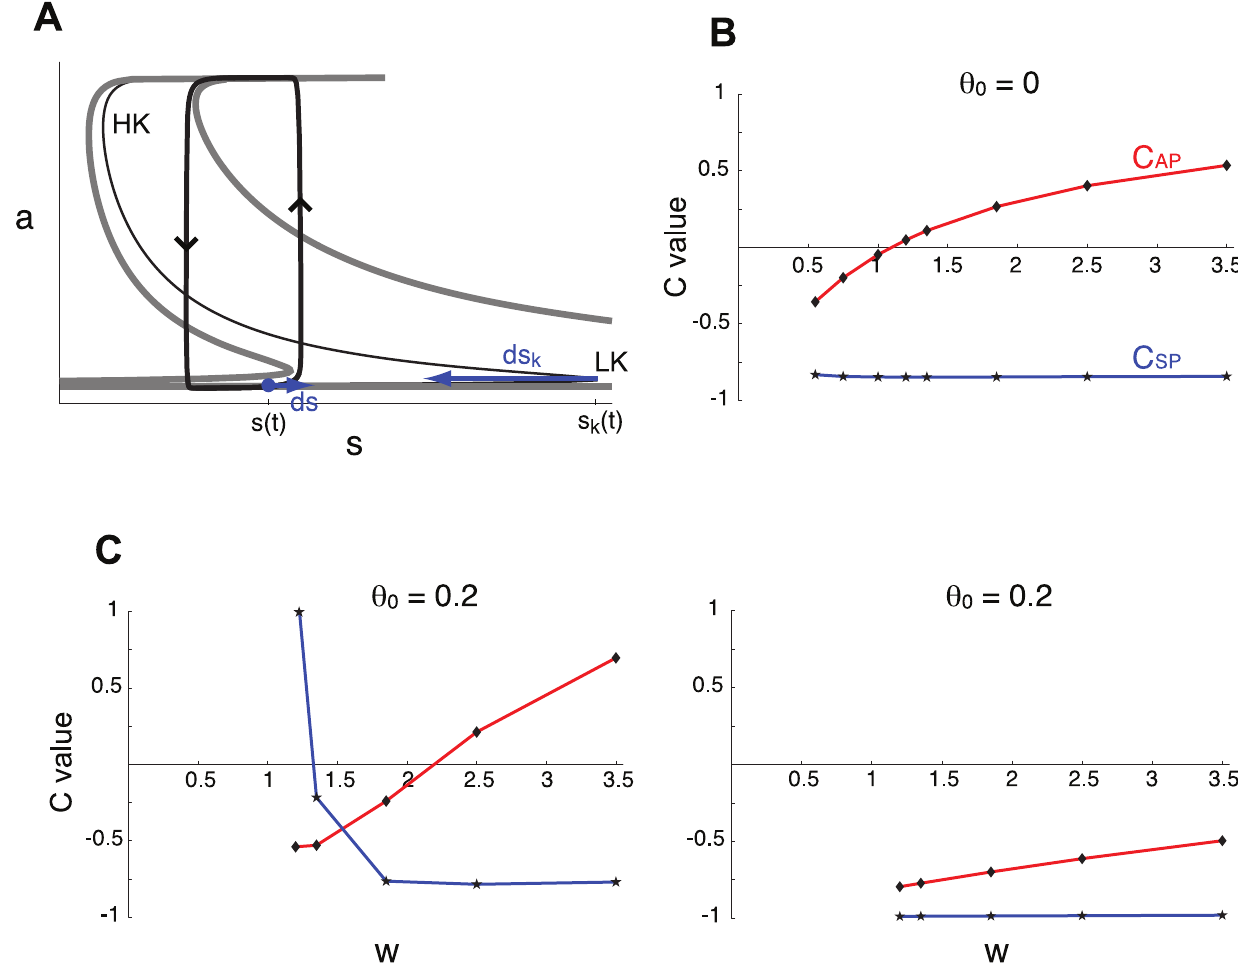
Figure 8. Alternate estimation of the relative contributions of each process using phase plane analysis. A. Representation of the system in the a , s -plane. The system trajectory is shown as a thick black curve with arrows at the transitions between activity phases. The trajectory follows the dynamic nullcline (thin black S-shaped curve) which moves left during the silent phase and reaches the thick gray nullcline on the left at episode onset. At onset, the trajectory reaches the low knee ( s (t)= s k (t)). During the active phase, the dynamic nullcline moves to the right toward the thick gray nullcline on the right. It reaches it at episode termination, as the trajectory reaches the high knee. Note that the lower portion of the nullcline is much more sensitive to h than the higher portion. LK, low knee; HK, high knee of the a-nullcline. B. Variations of C AP and C SP (calculated using the phase plane approximation illustrated in A) with w (for t h / t s =1 and h 0 =0). There is good agreement with the computational method based on small perturbations in the time constants (compare with Figure 6B). C. For large values of h 0 , such that high activity episodes require that h be close to 0, the computational calculation of the relative contributions (left panel) and the phase plane estimation (right panel) can disagree. In the case shown, t h / t s =0.1 (w=g=1), so the phase plane method estimates that h should control both active and silent phase (right panel). The disagreement with the computed C AP and C SP (left panel) is a result of the geometric argument used to estimate the contributions neglecting the fact that the speed of variation of s and h can slow down dramatically when approaching their asymptotic values (see text).